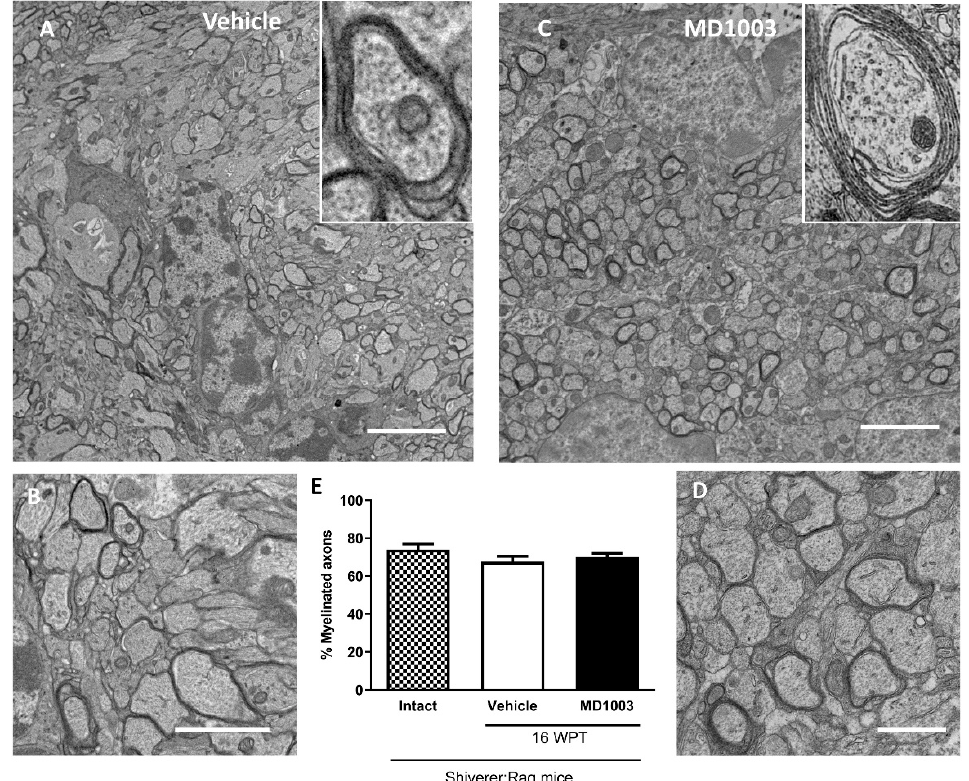
Figure 2. Electron microscopy evaluation of the percentage of myelinated axons by murine OLs in dysmyelinated shiverer mice. ( A – D ) Ultrastructure of endogenous uncompacted myelin in sagittal sections of the core of the corpus callosum 16 wpt with vehicle ( A , B ) and MD1003 ( C , D ). ( B , D ) and insets, are higher magnifications of ( A , C ). ( E ) Quantification of the percentage of myelinated axons revealed no significant difference between the vehicle, intact (not treated) and MD1003-treated mice. Two-way ANOVA was followed by the Tukey’s multiple comparison test ( n = 3 mice per group). Error bars represent SEMs. WPT: weeks post-treatment; scale bars in ( A , C ): 5 µm, ( B ): 2 µm and ( D ): 1 µm.